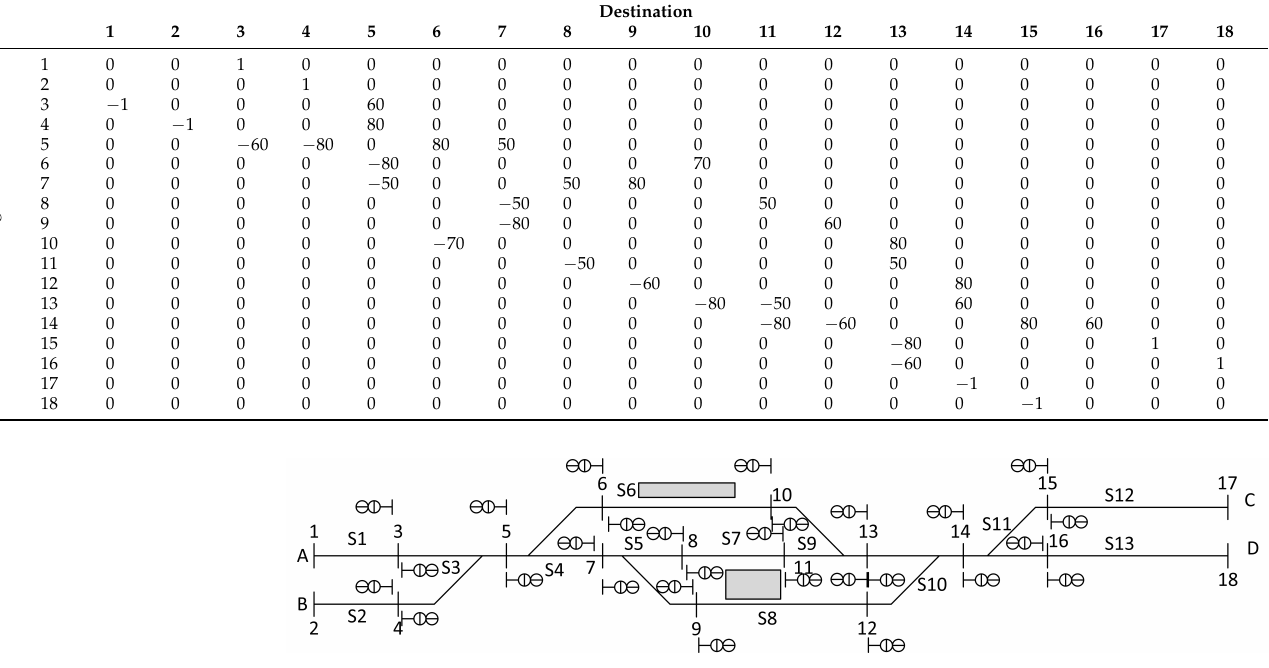
Figure 2. Simplified model of a